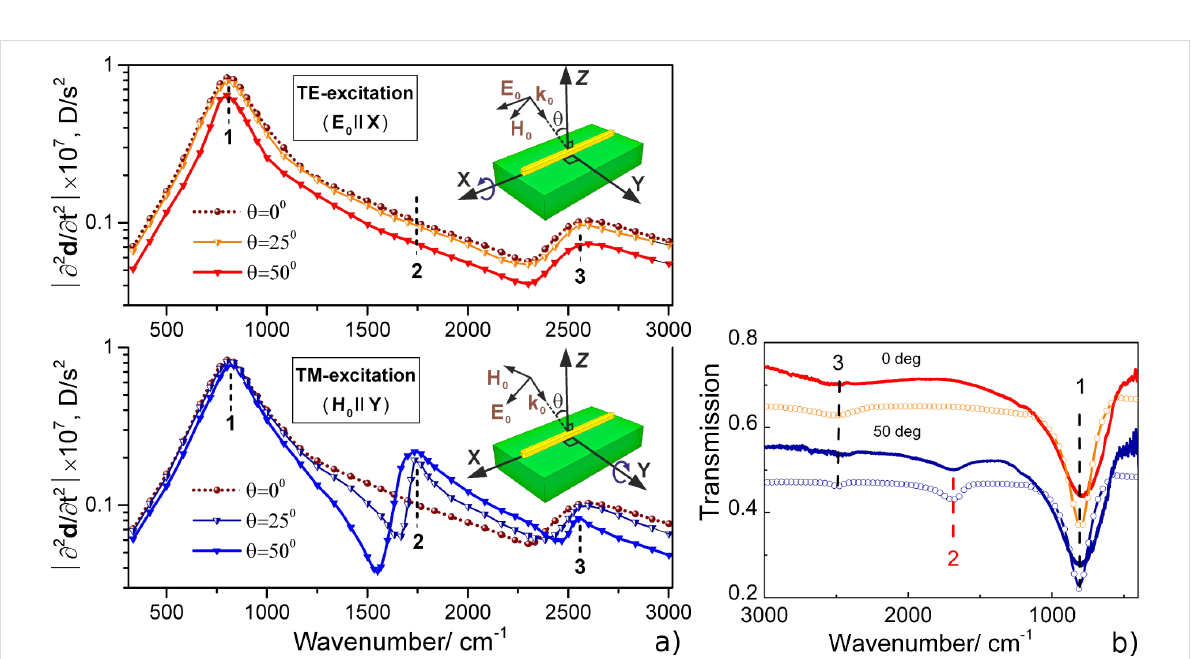
Figure 6: a) Evaluating the spectral behavior of the dipole radiation from a unit cell of the Si-backed array of linear nanoantennas at different angles of incidence θ and different polarizations: antenna length – 1800 nm, Y-period – 5000 nm. The graphs correspond to the wave power of P 0 · cos θ with P 0 = 1 W impinging upon the unit cell. b) Experimental (solid lines) and simulated (circles) SEIRA spectra of the linear nanoantennas for angles of incidence θ = 0 and 50° and TM polarization. The vertical dashed lines with numbers indicate the positions of the LSPR modes of the corresponding